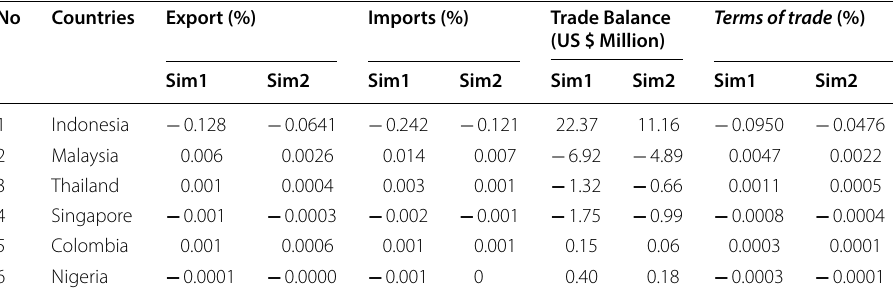
Table 3 Impact of stoppage of palm oil exports to the European Union against macroeconomic conditions of export, import, trade balance, and terms of trade in Indonesia and some of the World Major